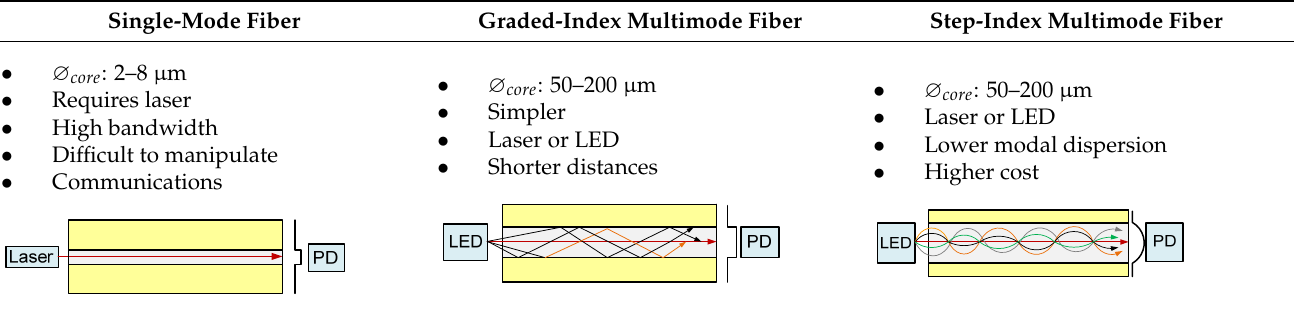
Table 4. The main characteristics of optical fibers.